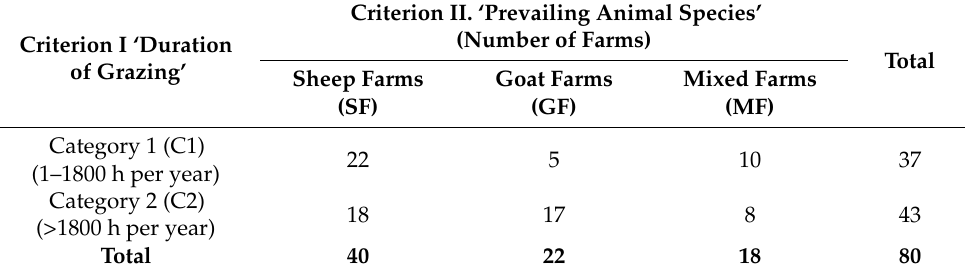
Table 1. Categorization of farms for the technical and economic analysis and number of sam- pled